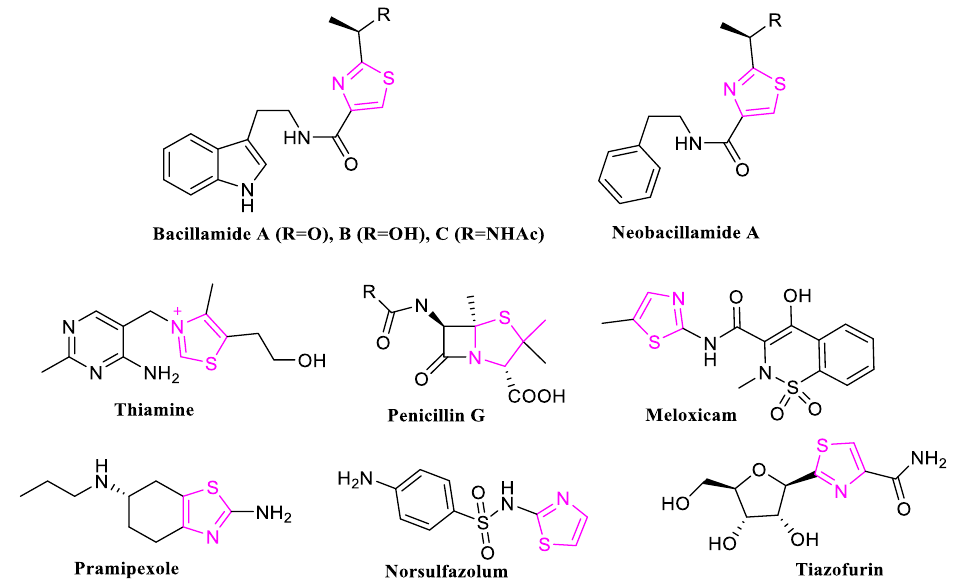
Figure 1. Natural and synthetic physiologically active compounds containing a thiazole cycle.